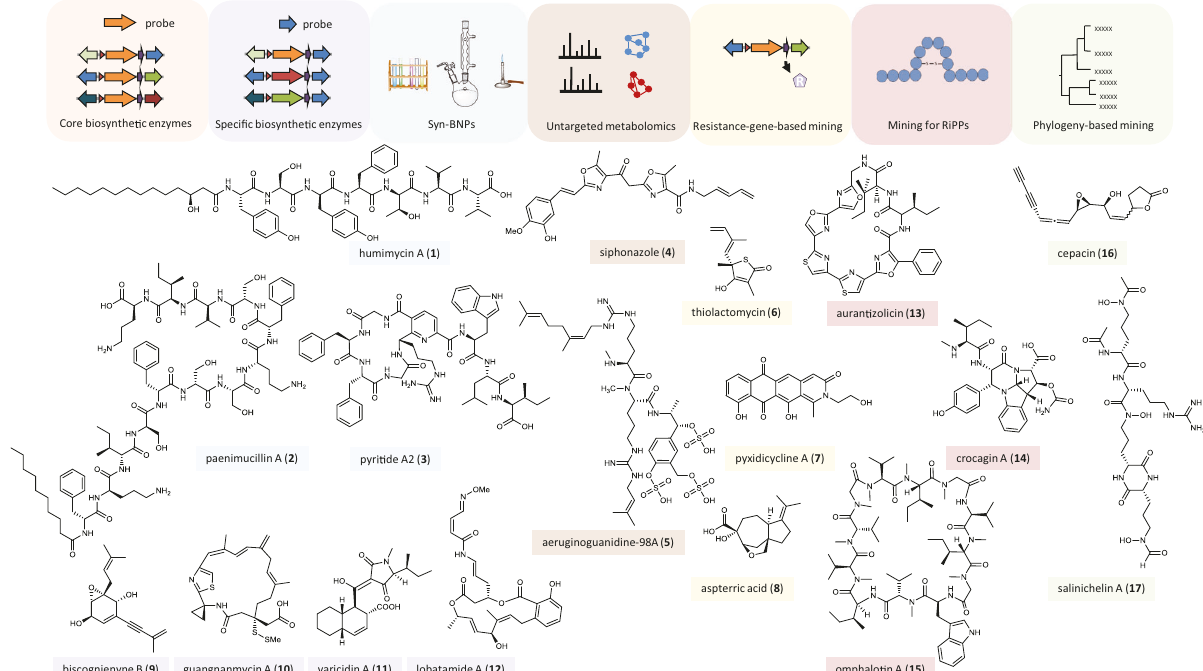
Fig. 1 Genome mining strategies. Tools and strategies for mining genomic data and examples of natural products discovered through these methods. (syn- BNP synthetic-bioinformatic natural products, RiPPs ribosomally synthesized and posttranslationally modi fi ed peptides). The color code of the boxes around the compound names and icons indicates the strategy that was applied for the discovery of the respective compound: light orange — mining for core biosynthetic enzymes, light violet — mining for speci fi c biosynthetic enzymes, light blue — bioinformatic structure prediction and chemical synthesis, brown — metabolomic approaches to link genes to metabolites and prioritize cryptic BGCs, yellow — resistance-genes-based genome mining, light red — genome mining for RiPPs, green — phylogeny-based genome